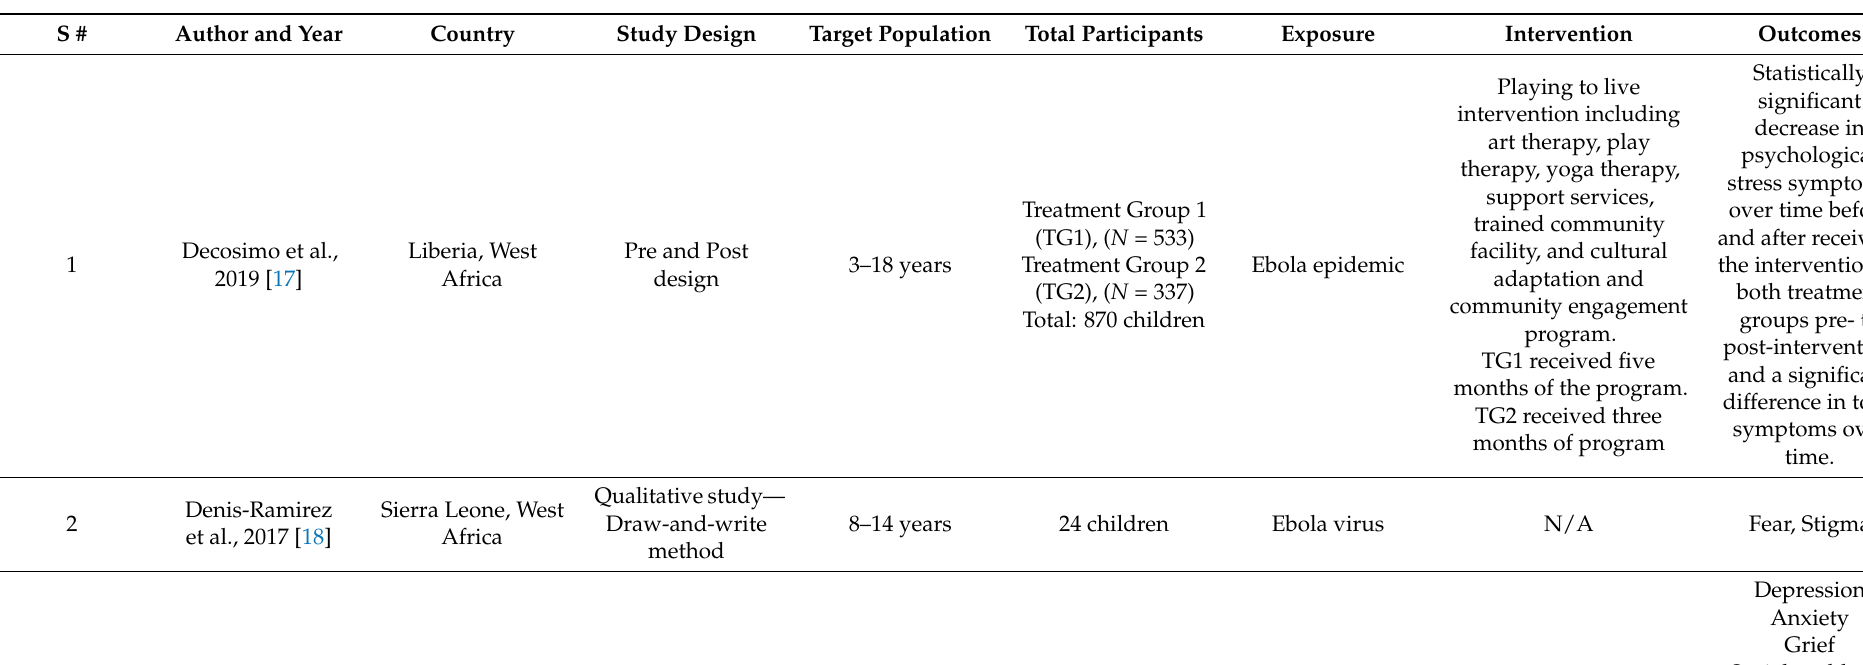
Table 2. Characteristics of included studies ( n =